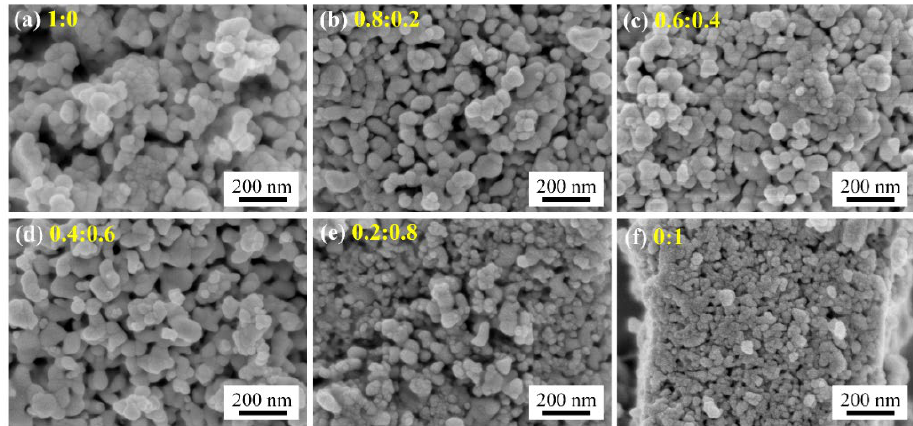
Figure 2. The SEM images of SmFeO 3 /YFeO 3 (e:f) nanomaterials: ( a ) 1:0, ( b ) 0.8:0.2, ( c ) 0.6:0.4, ( d ) 0.4:0.6, ( e ) 0.2:0.8, and ( f ) 0:1.